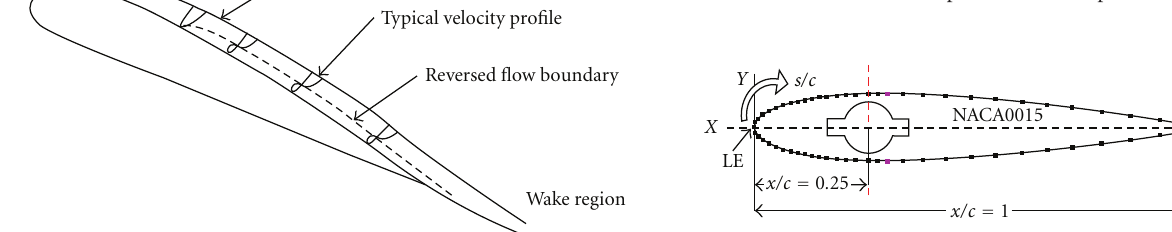
Figure 3: Experimental Set-up.